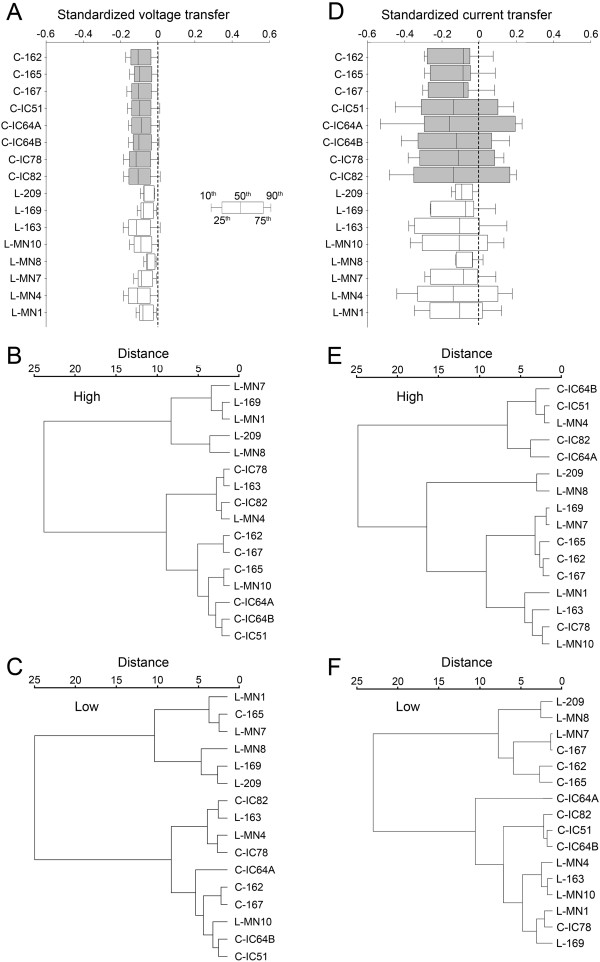
Voltage and current transfers in steady-state. Box plots show 10th, 25th, 50th, 75th and 90th percentiles of standardized and area weighted voltage- (A) and current transfers (D) in steady-state measured from dendritic points to the soma in limb moving MNs in the cervical (shaded boxes) and lumbar (open boxes) segments. Higher and lower percentiles were weighted relative to the median (50th percentile) and used as descriptors for cluster analysis of MNs. The 10th and 90th as well as the 25th and 75th percentiles are shown by the wings and by the borders of boxes respectively, the median is marked by the line within the box (see insert). Dendrograms show segmental segregation tendencies between the cervical and lumbar MNs based on voltage and current transfer properties under high (voltage: part B, current: part E) and low (voltage: part C, current: part F) background synaptic activities. Different levels of synaptic background activities were modeled by varying the specific dendritic membrane resistance (Rmd). High activity: Rmd = 5000 Ωcm2 and low activity: Rmd = 50000 Ωcm2. In cluster analyses shown, the Ward’s method was used and the weighting factors for percentiles were: 0.2 for the 10th and 90th percentiles and 0.8 for the 25th and 75th percentiles. MN labels starting with letters C and L stand for the cervical and lumbar neurons respectively.